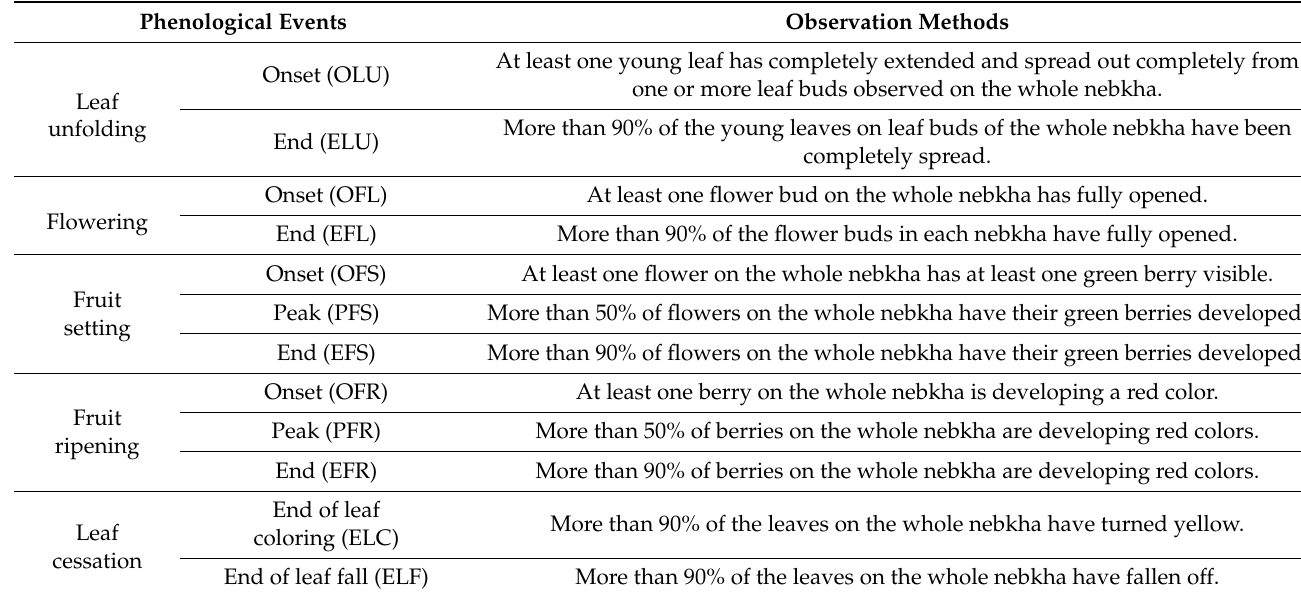
Table 4. Phenological observation and observation methods of N . tangutorum